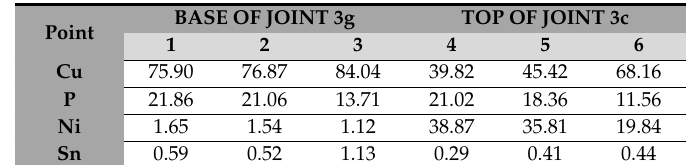
Table 2. Composition (at. %) of di ff erent points at the top and base of the joint sample brazed at 680 ◦ C for 10 min according to the points marked in Figure